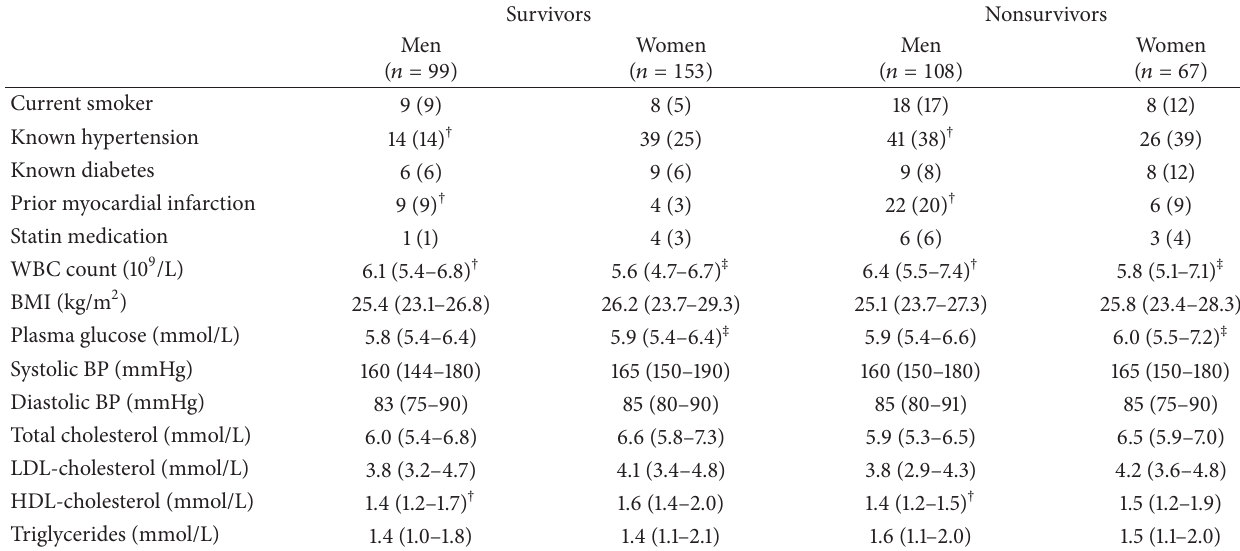
Table 1: Sex-specific baseline characteristics of the study cohort according to survival status. Categorical variables are shown as number (%) and continuous variables as median (interquartile